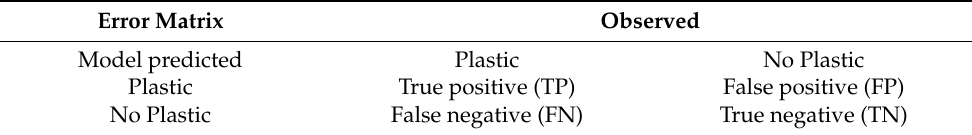
Table 4. Structure of an Error/Confusion Matrix. Error Matrix Observed Model predicted Plastic No Plastic Plastic True positive (TP) No